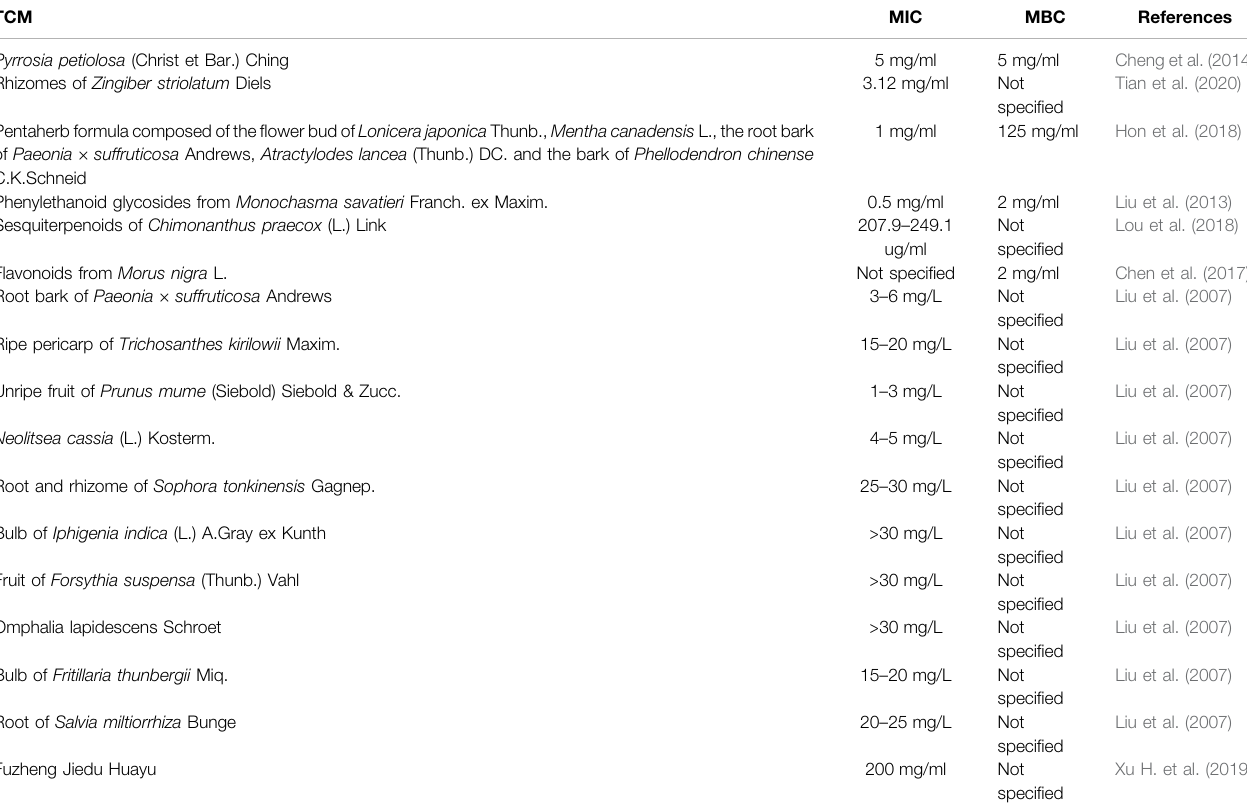
TABLE 4 | Summaries of the bactericidal effects on TCM on P. aeruginosa . TCM MIC